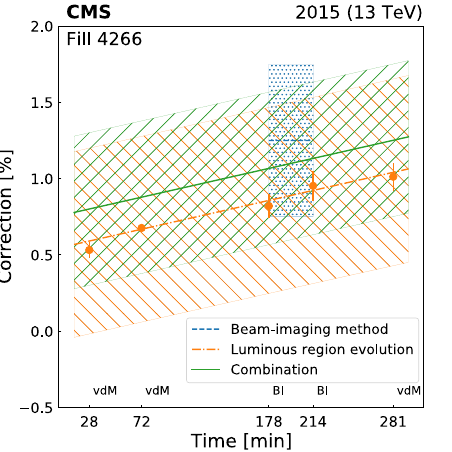
Fig. 14 Ratio of the σ vis evaluated from the overlap integral of the reconstructed single-bunch profiles in two (BI method) or three (lumi- nousregionevolution)spatialdimensionstothatdeterminedbythevdM method, assuming factorization, and their combination. The central val- ues are displayed as points or with a line while the corresponding full